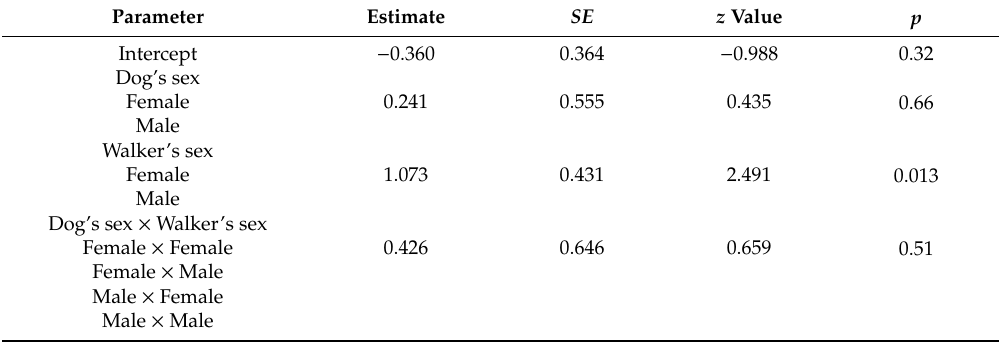
Table 3. E ff ects of sex of dog and sex of walker on likelihood of defecation by dogs during a 20-min walk.